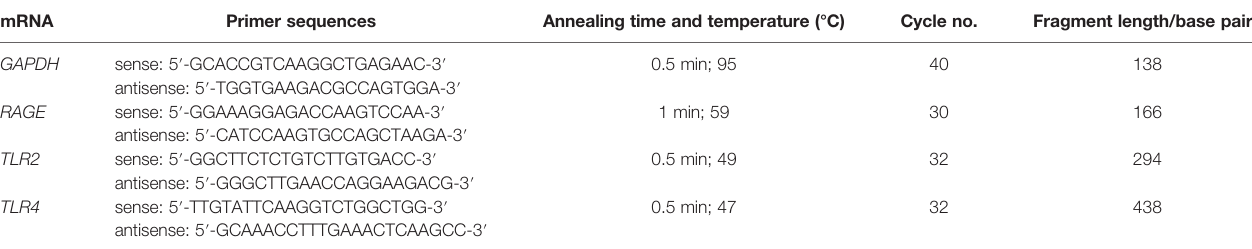
TABLE 1 | Primer sequences and PCR